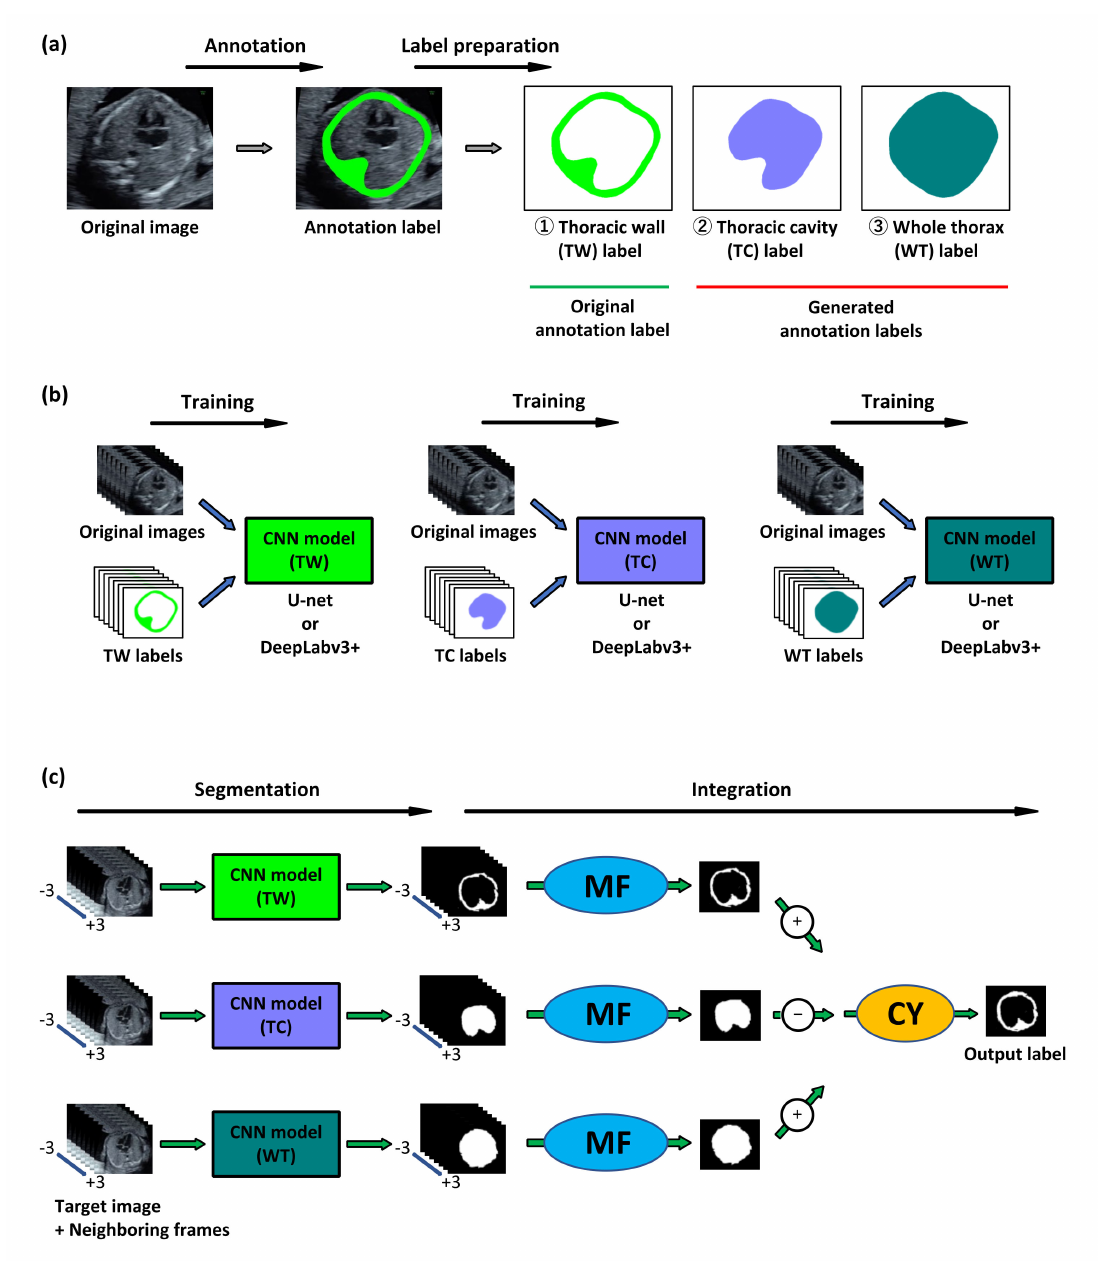
Figure 1. Outline of our proposed method, MFCY (Multi-Frame + Cylinder method). ( a ) Labels for supervised learning. Labels of the thoracic wall (TW) were annotated in the four-chamber-view (4CV) images extracted from fetal ultrasound videos. The thoracic cavity (TC) and the whole thorax (WT) labels were automatically generated based on the TW labels. These three labels were used for supervised learning. ( b ) Model training. Each convolutional neural network (CNN) model was trained using the original images and their respective labels. U-net and DeepLabv3 + were employed as CNNs. ( c ) Prediction. During the prediction phase, we extracted the target 4CV images and their neighboring frames from fetal ultrasound videos. These images were transmitted into the trained CNN models (TW, TC, and WT) to obtain the prediction labels corresponding to each image. The prediction labels corresponding to TW, TC, and WT were integrated into a single prediction label respectively via MF. Three independent labels were integrated using CY to obtain the prediction label which is the output of the thoracic wall segmentation using